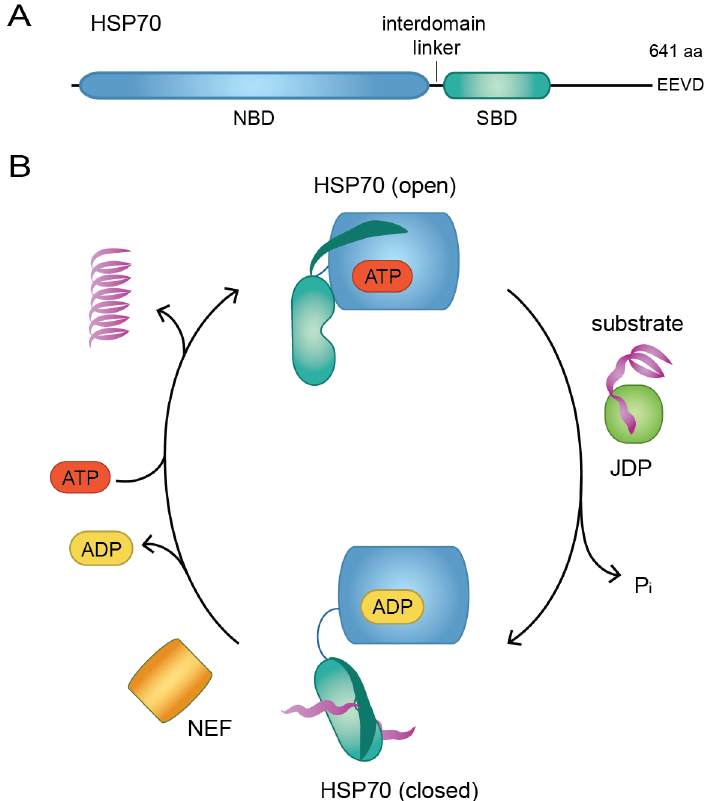
Figure 1. The substrate binding/release cycle of HSP70. ( a ) Schematic overview of the HSP70 domain structure. NBD: nucleotide-binding domain, SBD: substrate-binding domain, aa: amino acids. ( b ) The ATP-bound open conformation of HSP70 engages with a substrate-bound J-domain protein (JDP), which causes ATP hydrolysis and transfer of the substrate to HSP70 leading it to switch into its closed conformation. A nucleotide exchange factor (NEF) mediates ADP release, which permits ATP binding and results in opening of HSP70 and subsequent substrate release.